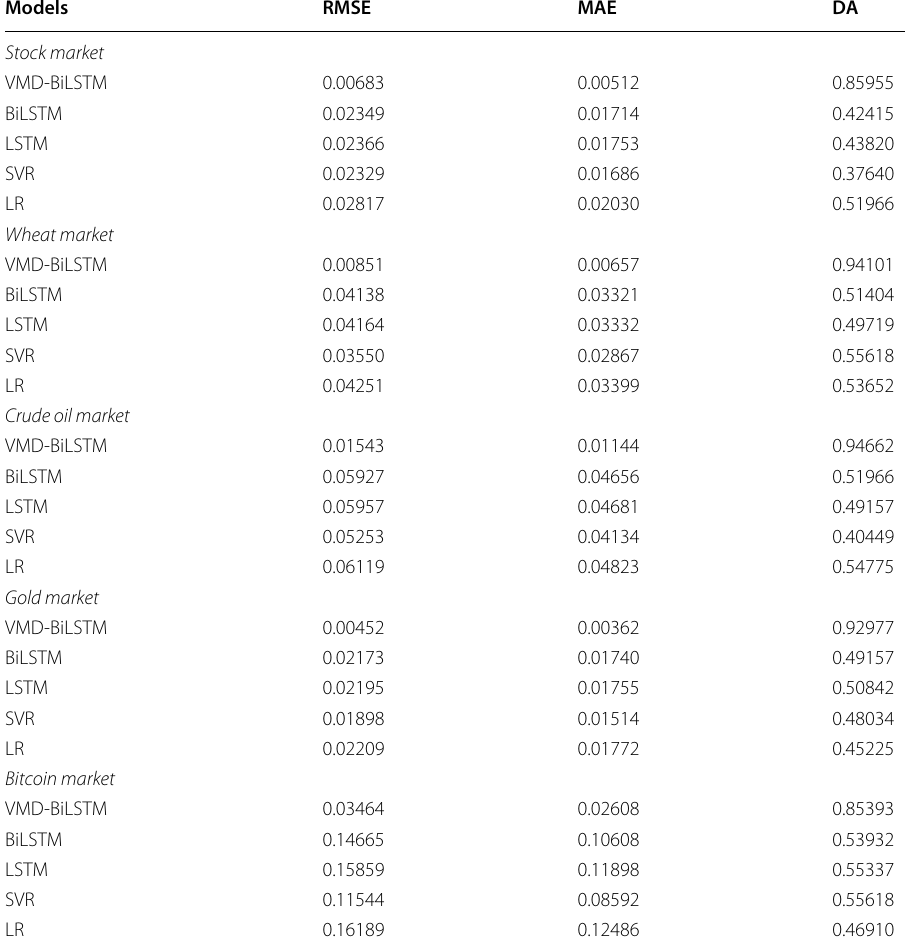
Table 2 Comparison of prediction performances for the proposed model and benchmarks